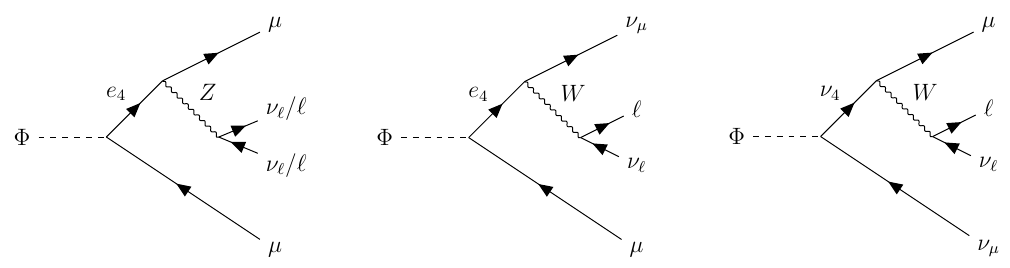
Figure 1 . Leptonic cascade decays of a heavy neutral scalar ( Φ ) through a charged ( e 4 ) and neutral ( ν 4 ) vectorlike lepton. The decay in the left panel contributes to the 3 / 4 ‘ search if Z → ‘‘ , while the other decay modes contribute to the 2 ‘ + E miss TikZ-FeynHand [37,